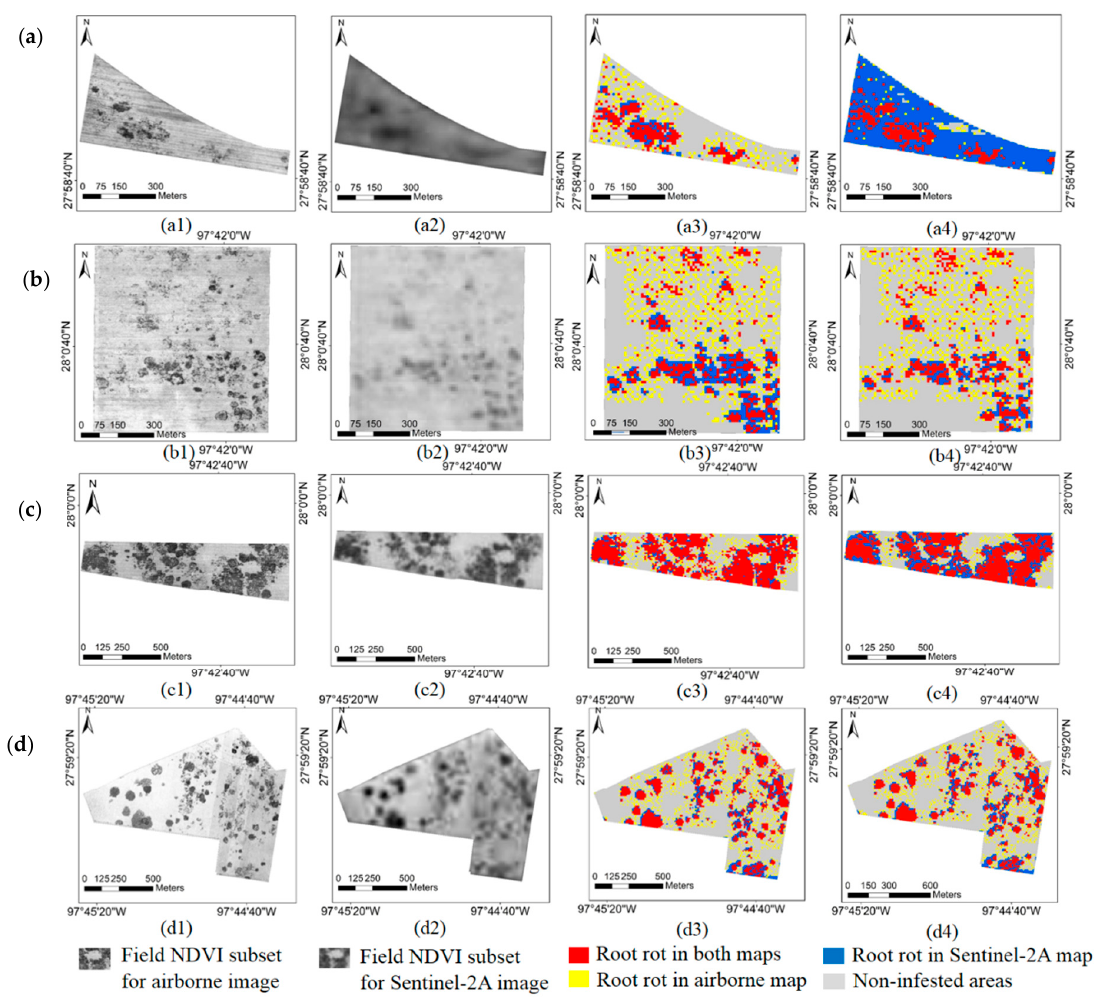
Figure 9. Field subsets for overlaid cotton root rot classification map between the airborne image and the Sentinel-2A image. ( a ) Field 1, ( b ) Field 5, ( c ) Field 10, and ( d ) Field 14; (1) Field normalized difference vegetation index (NDVI) subset for airborne image; (2) field normalized difference vegetation index (NDVI) subset for Sentinel-2A image; (3) overlaid classification map for airborne image and field subset Sentinel-2A image; (4) overlaid classification map for airborne image and whole study area Sentinel-2A image.